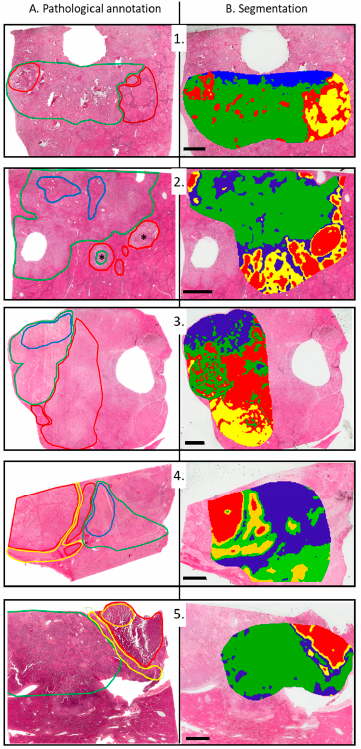
Figure 2. Pathological annotation compared to MALDI-MSI segmentation for the 5 cHCC-CCA cases. ( A ) Pathological annotations on HES obtained by two experienced pathologists following re-reading. The different colors indicate the areas of interest. Color legend: green: areas of cholangiocarcinoma; bright red: areas of hepatocarcinoma; blue: fibrosis derived from cholangiocarcinoma; yellow: fibrosis derived from hepatocarcinoma; orange: macrotrabecular area in hepatocarcinoma; deep red: non- tumoral liver. Two asterisks: MVI. ( B ) MALDI-MSI segmentation obtained separately and overlaid with successive HES slices. Color corresponds to similar spectra groups: red: HCC; yellow: fibrotic component including capsule of HCC and fibrosis around cirrhotic nodules; green: iCCA; blue: fibrotic component in iCCA. Number 1 to 5 correspond to the five cases included. Scale bar = 3